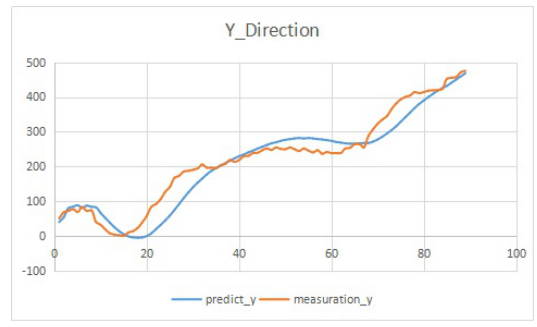
Figure 13: Y coordinate of predicted point and measured